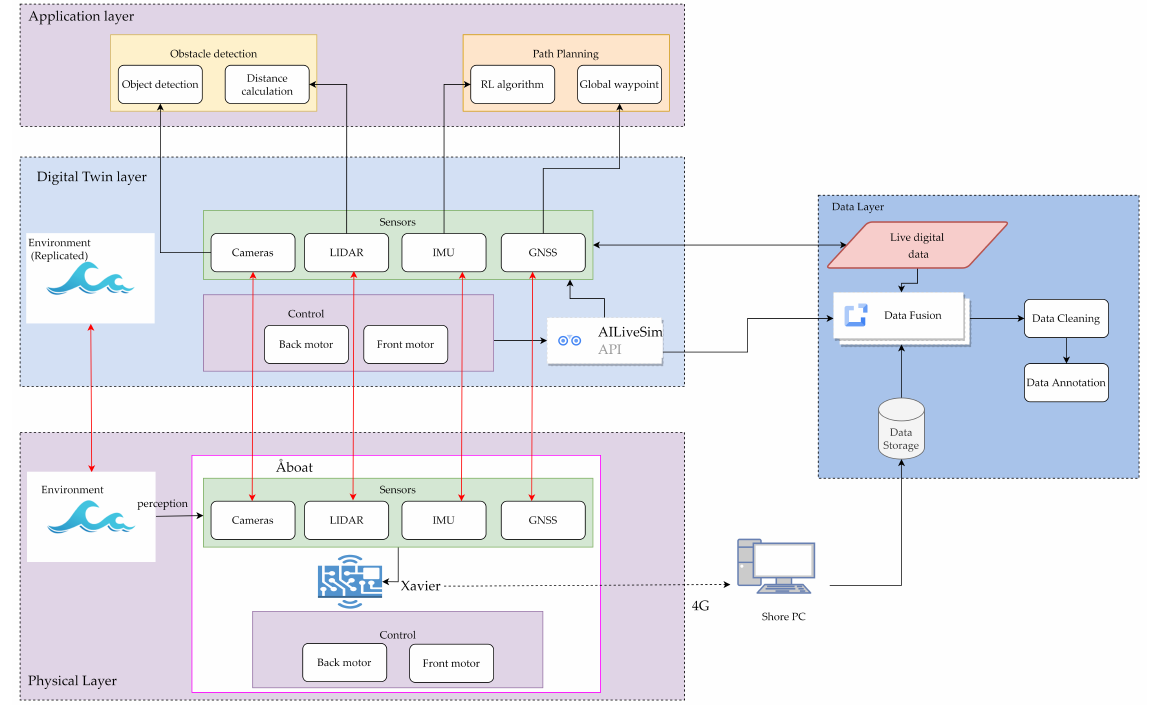
Figure 1. Application framework for the digital twin-driven AMSV system. The framework consists of four layers to create a cohesive and integrated digital twin system that accelerates model training and deployment for AMSVs.